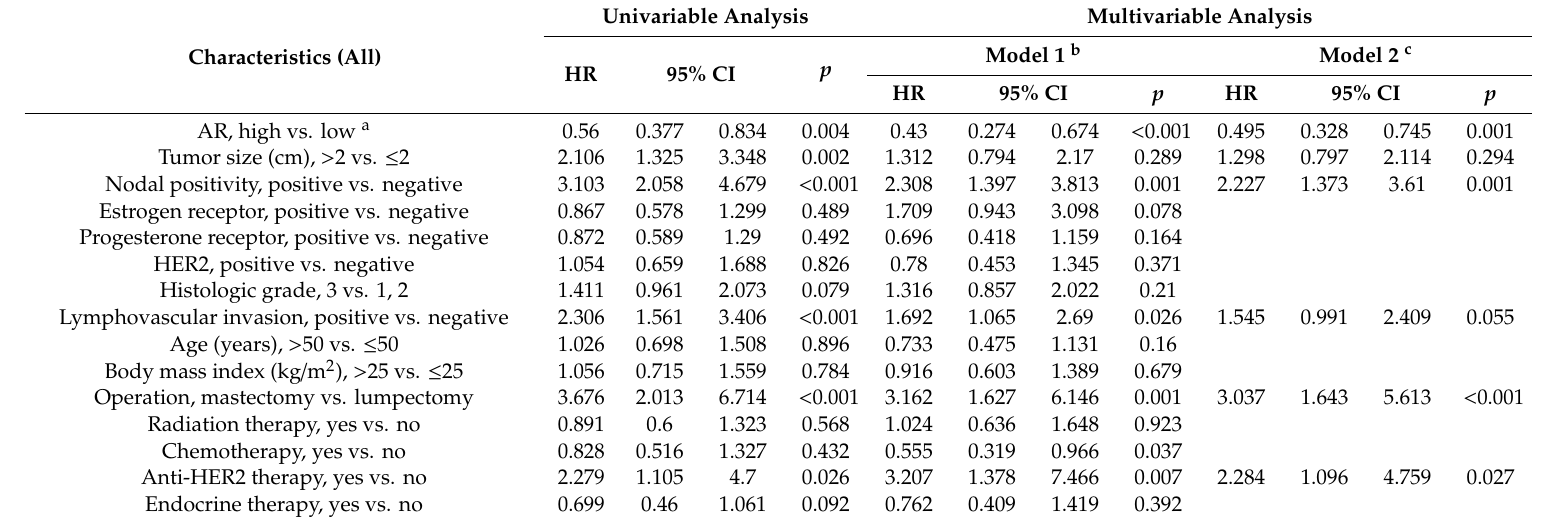
Table 3. Univariable and multivariable analyses regarding disease-free